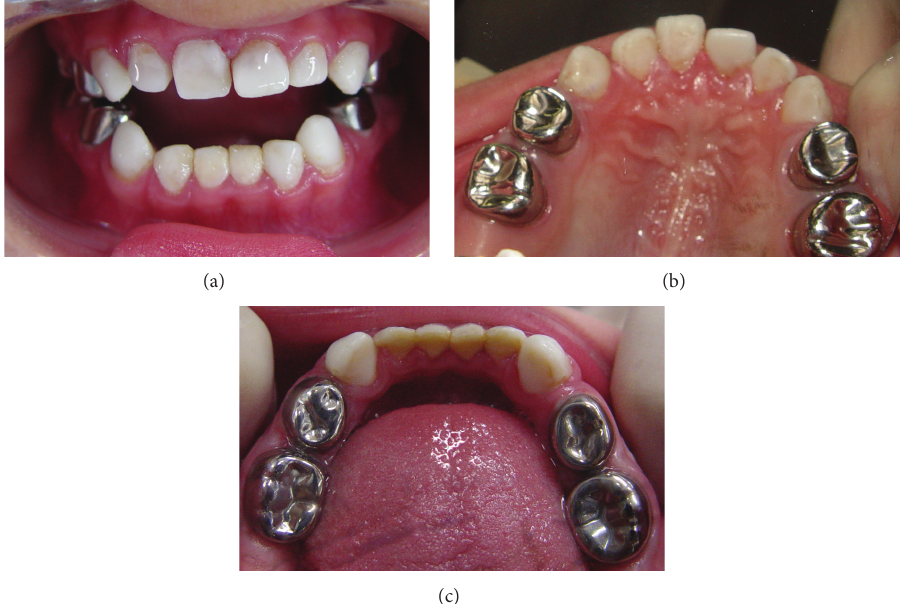
Figure 4: (a) Frontal view of the completed treatment with stainless steel crowns and composite resin-filled celluloid forms in a 5-year-old child; (b) maxillary occlusal view; (c) mandibular occlusal